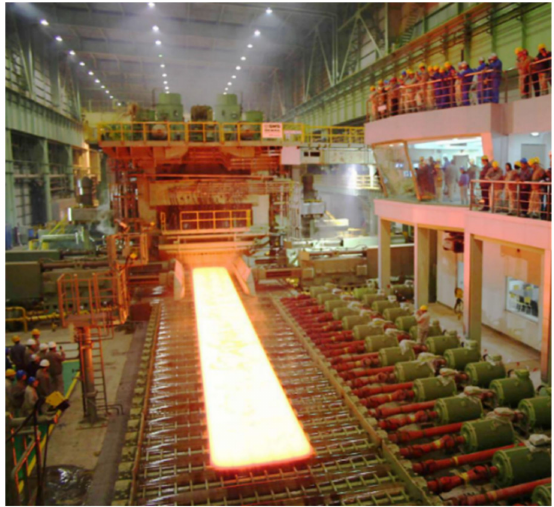
Figure 2. The output of feed from Mill 5000